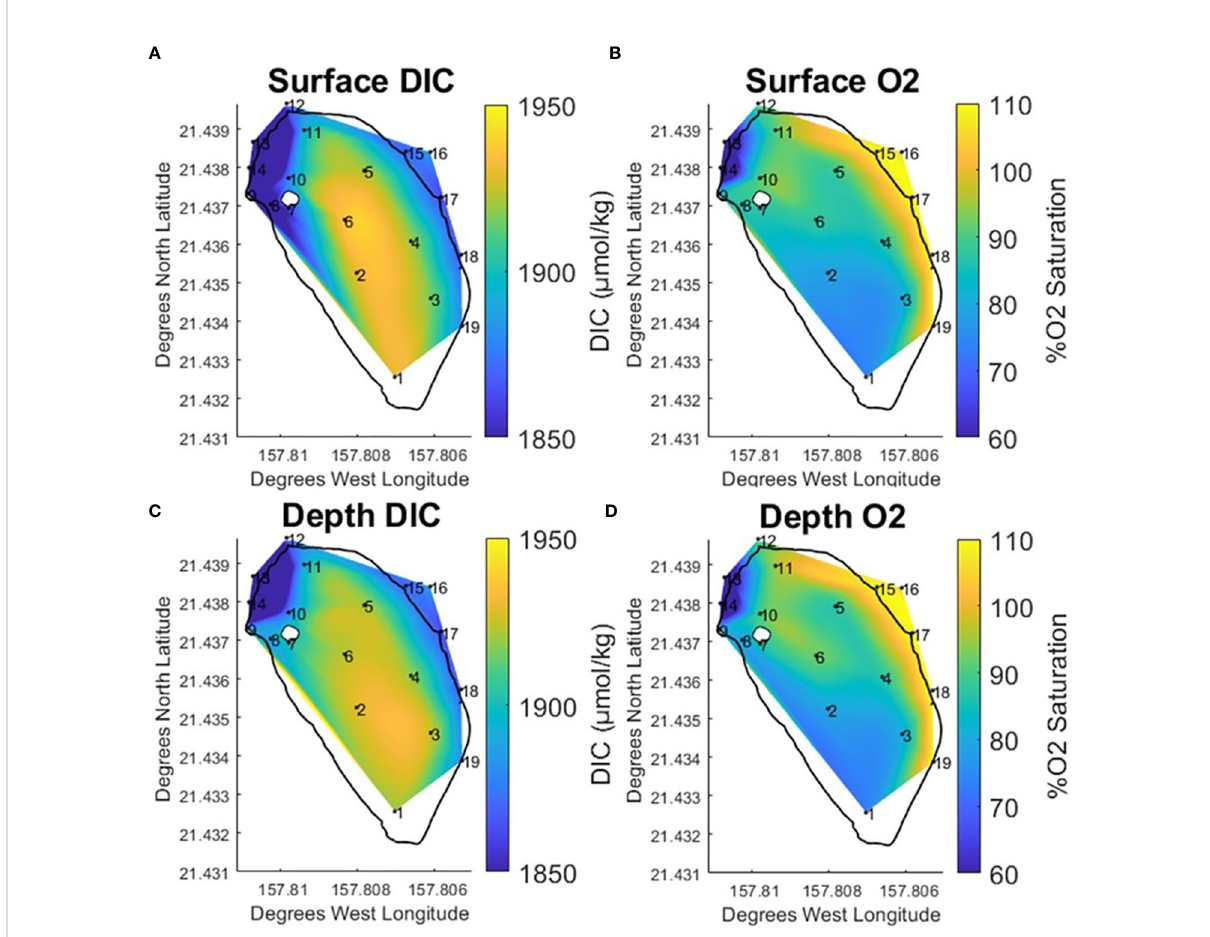
FIGURE 6 Temporally averaged contours for surface DIC (A) and % O2 Saturation (B) and Depth DIC (C) and % O2 Saturation (D) at He ‘ eia Fishpond during the study period. Stations IDs (numbered in black) are plotted on contour to show sampling